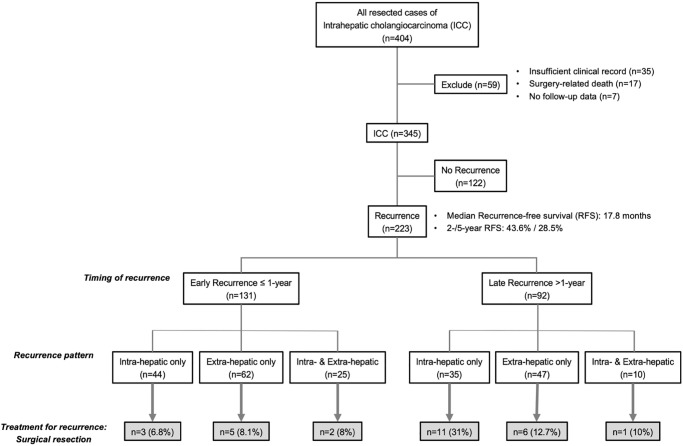
Inclusion and exclusion criteria applied in the present study.